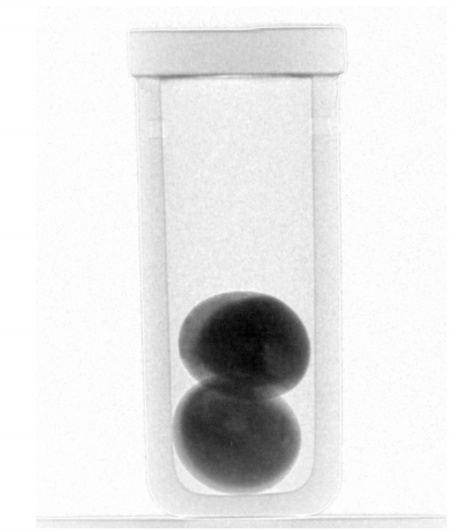
Figure 6. Room temperature radiograph of two heterogeneous arc-melted CoCrCu samples stacked inside a small crucible. The lighter regions are the Cu-rich phase (>95%) and are segregated to the surface of the buttons as well as randomly distributed globules inside the bulk. The darker regions are Co-Cr-rich and make up the rest of the arc-melted